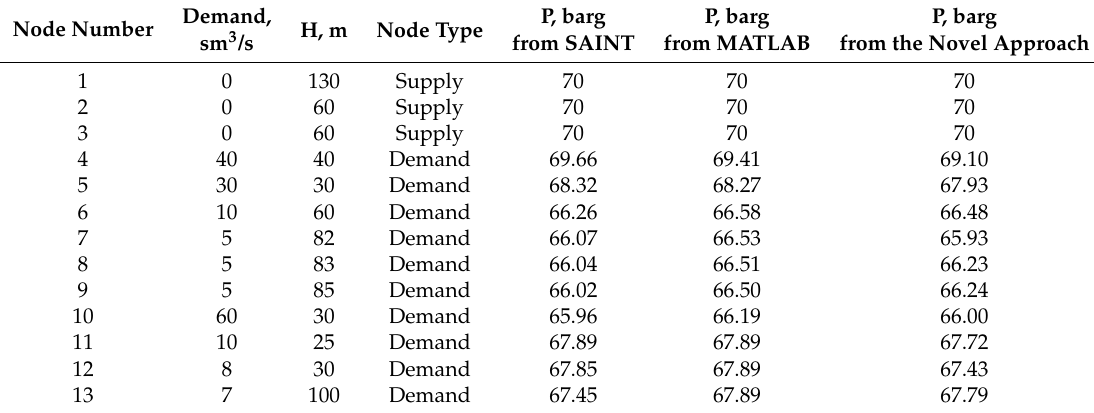
Table 3. Demand and supply nodes’ details with pressure results from SAINT, MATLAB, and the novel approach at each node.